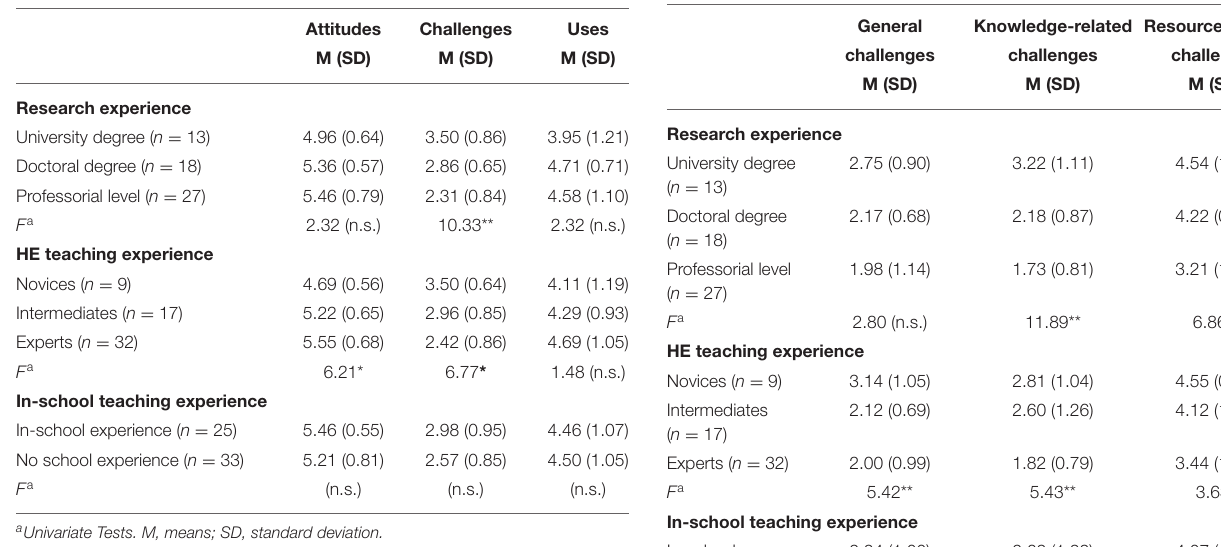
TABLE 8 | Differences in the mean scores of the teacher educators on challenges and F